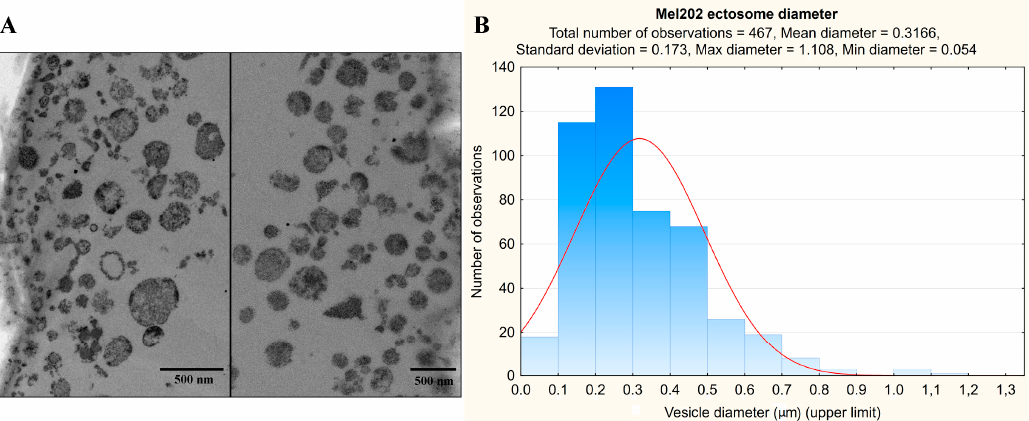
Figure 1. TEM analysis of Mel202-derived ectosomes. Samples were fixed with 2.5% glutaraldehyde, postfixed in 1% osmium tetroxide, dehydrated by passing them through a graded ethanol series, and embedded in epoxy resin. Ultrathin sections were contrasted using uranyl acetate and lead citrate. The sections were viewed on a JEOL JEM 2100HT TEM at 80 kV ( A ). Subsequently, diameters of n = 467 ectosomes were measured with the use of ImageJ software ( B ).